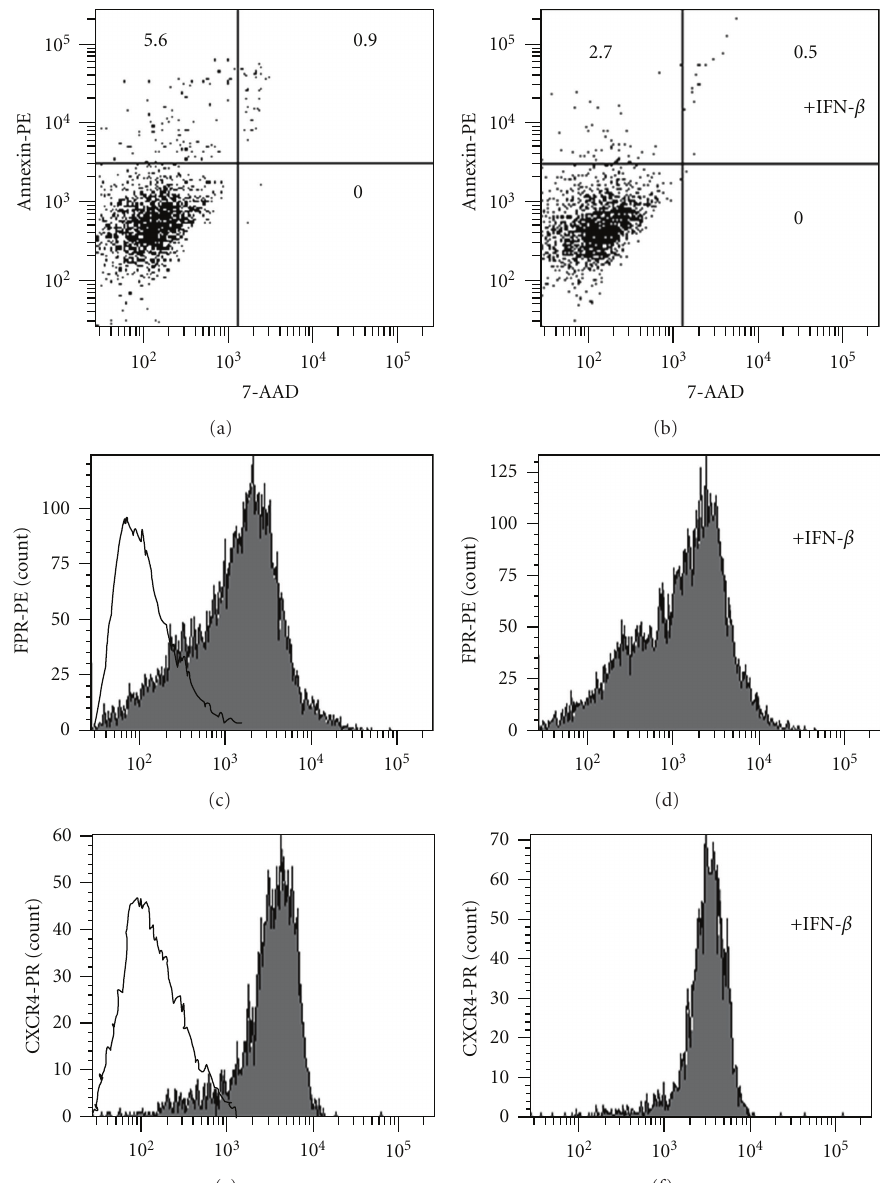
Figure 8: IFN- β inhibition of calcium flux is not due to apoptosis or chemokine receptor down regulation . Monocytes were incubated with IFN- β for 20 hours, and the degree of apoptosis in untreated and IFN- β treated monocytes was determined by measuring Annexin-PE staining relative to the cell viability dye 7-AAD as described in Section 2 (a), unstimulated; (b), IFN- β -stimulated. Annexin-PE fluorescence is shown on the y -axis and 7-AAD on the x -axis. The percent (%) fluorescent events (total of 10000 measurements) are shown in each quadrant. CXCR4 and FPR expression was determined using FACS as described in Section 2. FPR expression levels are shown for control (solidline) and unstimulated (c) and IFN- β -stimulated (d) cells. CXCR4 expression levels are alsoshownfor unstimulated (e) and stimulated cells (f). Cells were incubated for 20 hours with IFN- β prior to measuring CXCR4 and FPR expression